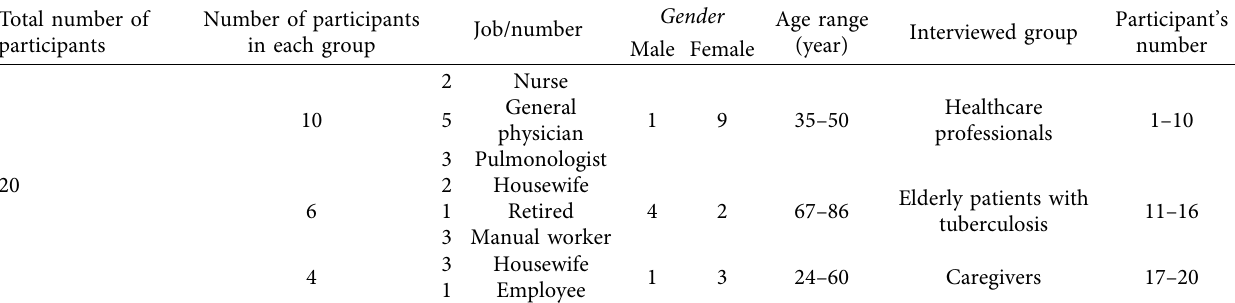
Figure 1: Article selection process. Table 1: Characteristics of participants in